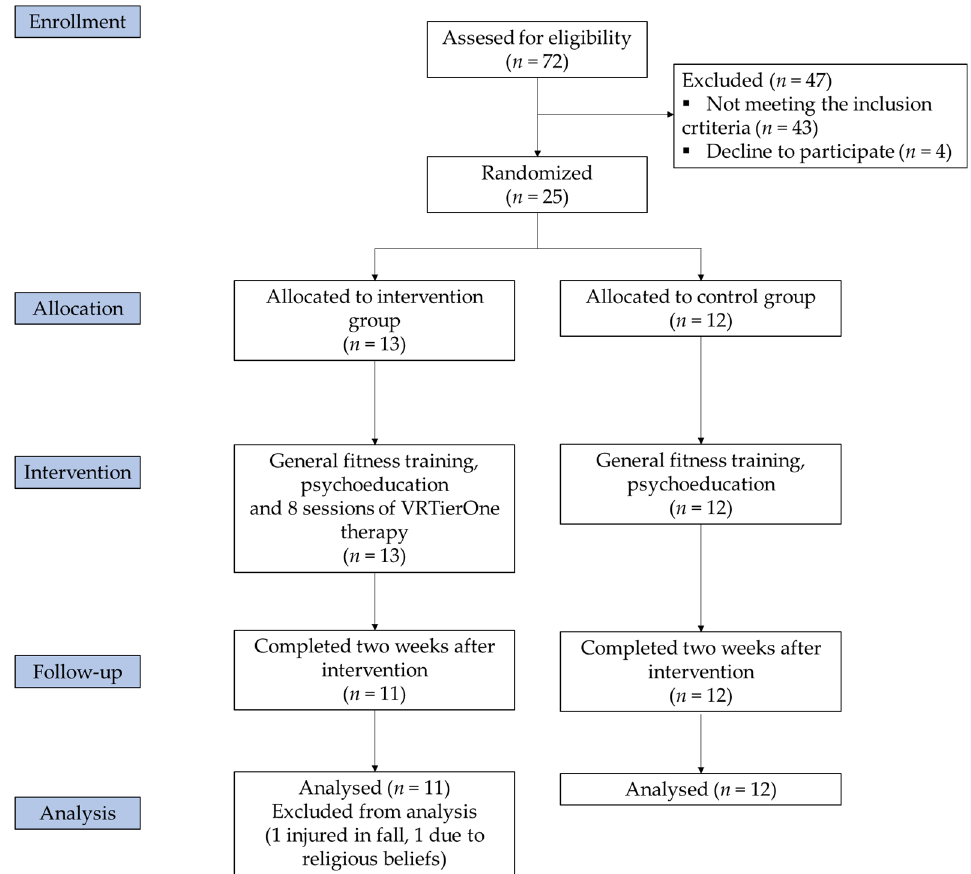
Figure 1. Study flow diagram .